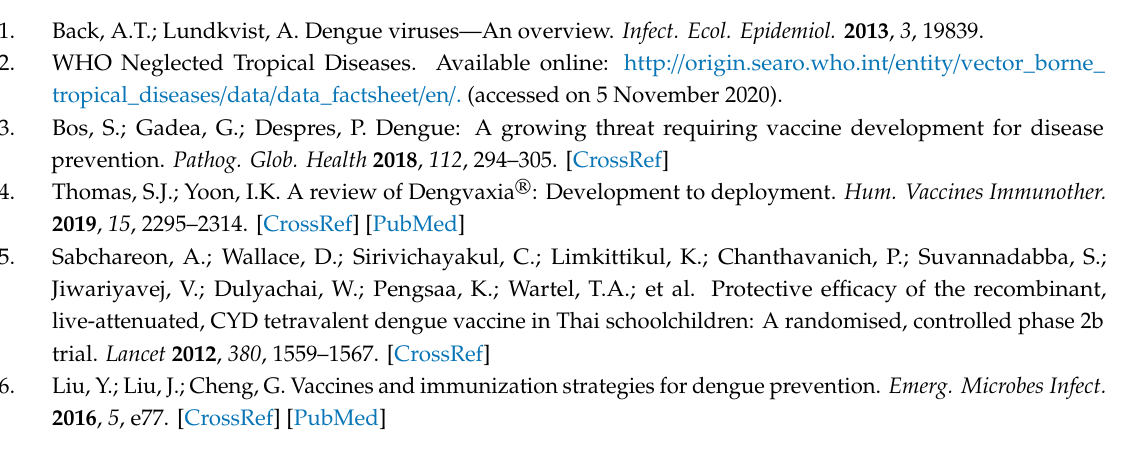
Table S1: Primer sequences for real-time PCR; Table S2: The ability of Pep-RTYM to inhibit virus entry by real-time PCR; Figure S1: Cytotoxicity of bioactive peptide inhibitors in Huh7 cells; Figure S2: DENV envelope protein sequence